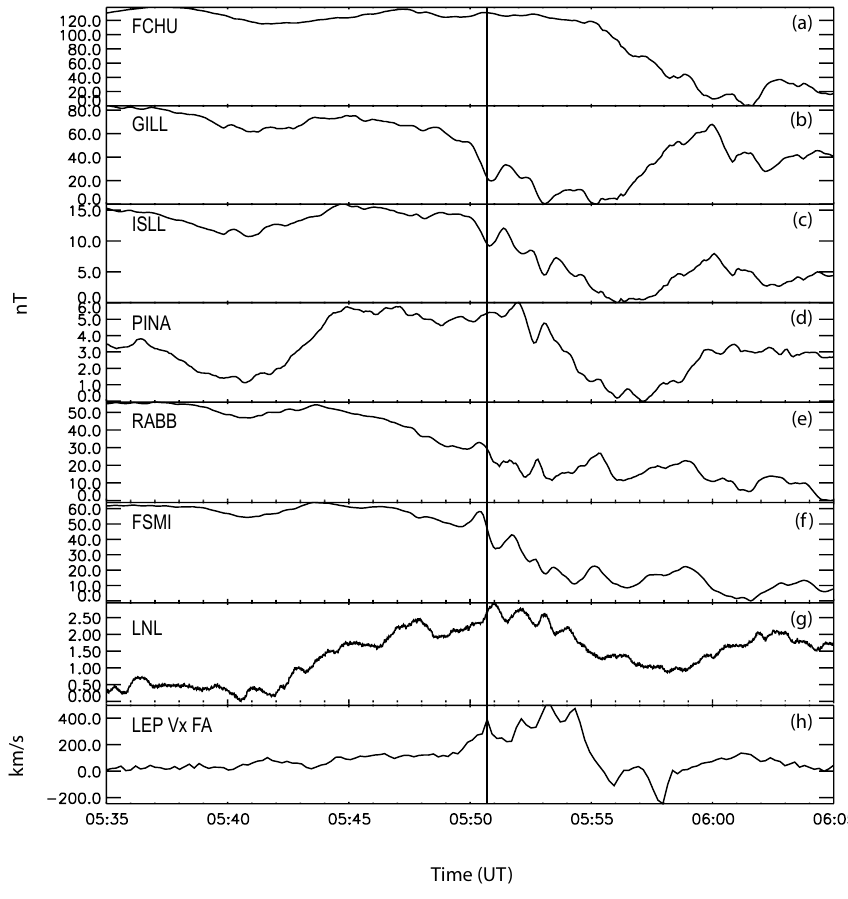
Fig. 3. A stack plot of the H-component magnetic field for selected CARISMA magnetometers and the Los Alamos (LNL) magnetometer, panels (a) – (g) , and the v ⊥ x plasma flow observed by Geotail, panel (h) , between 05:35–06:05UT. The vertical line represents the time of maximum velocity of the first Geotail FB. Note that Pi2 pulsations at RABB and GILL are clearly evident before the initial flow